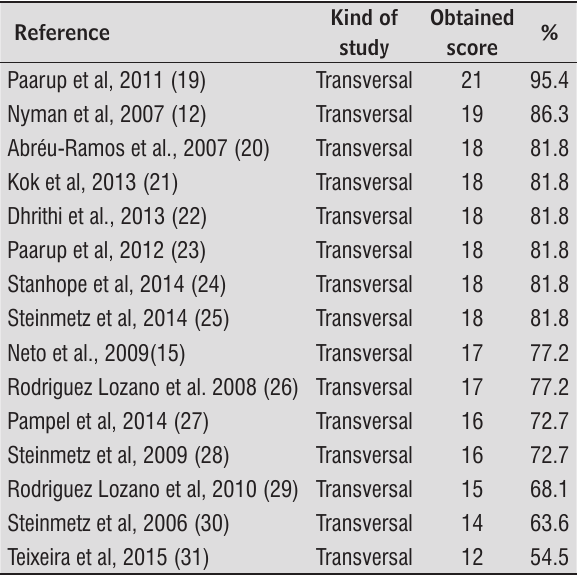
Table 2 - Score and quality percentage of articles from the STROBE criteria, Brasilia,